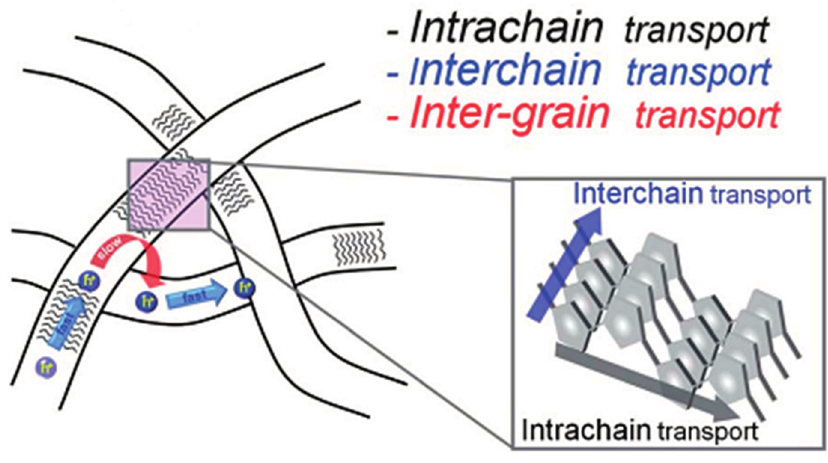
Figure 2. Schematic of the face-face stacking of polymer chains in P3AT nanowires. Reproduced from [58] with permission from The Royal Society of